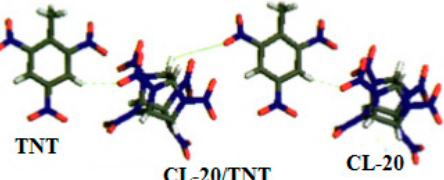
Figure 1. Intermolecular hydrogen bond of CL-20 / TNT cocrystal [8], with permission from Han Neng Cai Liao, 2012.